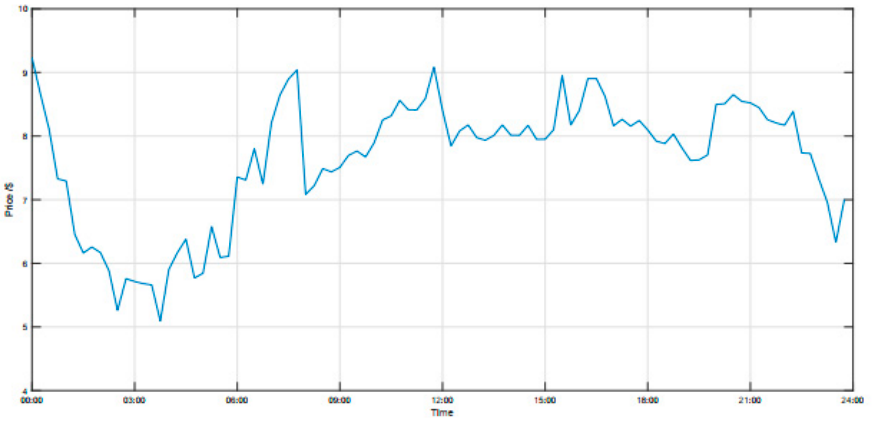
Figure 3. The aggregator’s optimal purchase prices.